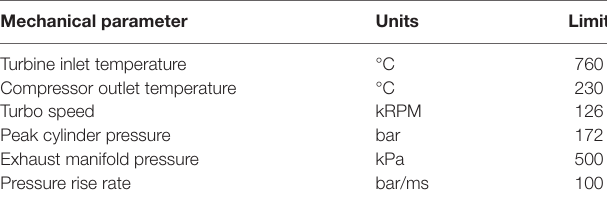
TaBle 1 | Mechanical constraints.